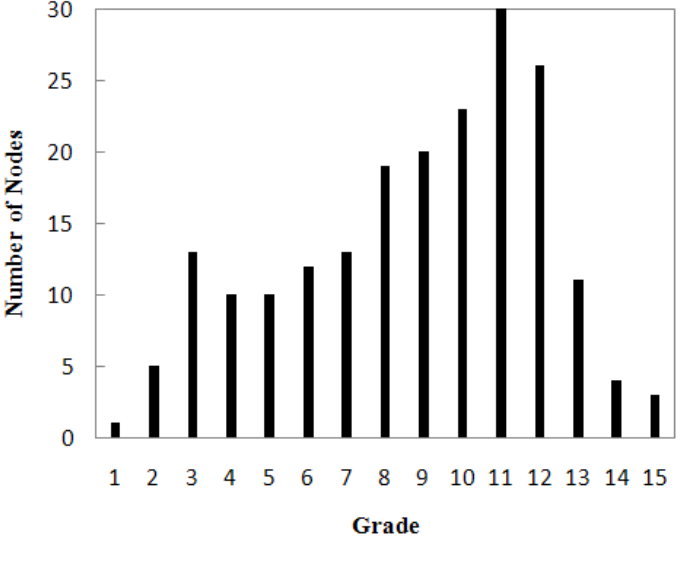
Figure 8. The number of nodes in each grade in the random topology